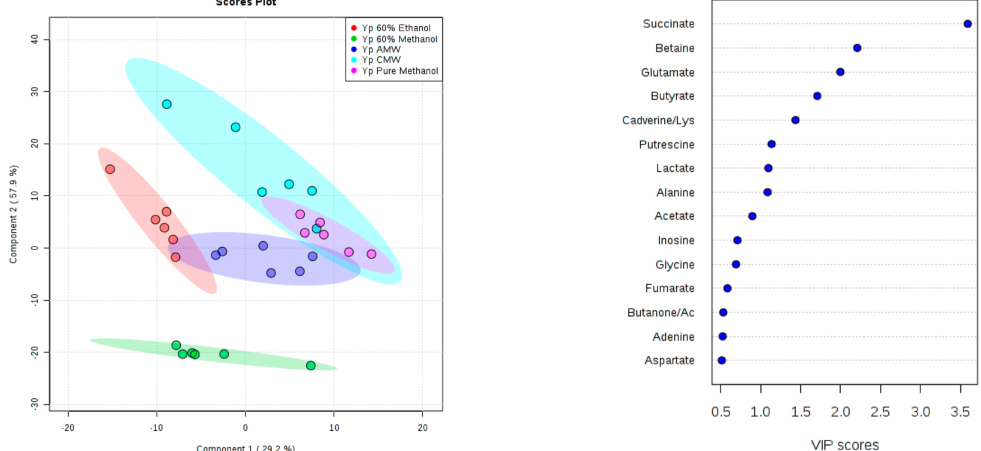
Figure 6. PLS-DA score plot ( left ) and VIP score plot derived from PLS-DA analysis ( right ) based on 36 identified compound peak areas of the polar fraction of the metabolome of Y. pseudotuberculosis of the different extraction methods: 60% methanol, PM, 60% ETH, AMW; 2:2:1, and CMW; 2:1:1. Ac: